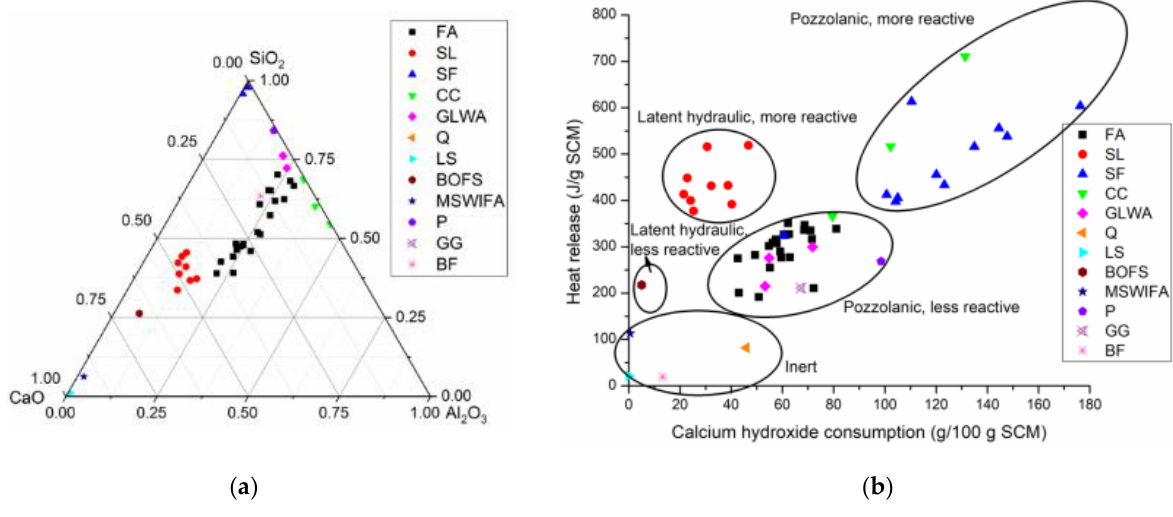
Figure 1. Characteristic of various SCMs: ( a ) ternary phase diagram showing SiO2, Al2O3, and CaO amounts for various SCMs [4]; ( b ) results from isothermal calorimetry and thermogravimetry analysis on various types of SCMs and their classification. Key to SCM types: fly ash (FA), ground granulated blast furnace slag (SL), silica fume (SF), calcinated clay (CC), ground lightweight aggregates (GLWA), quartz (Q), ground limestone (LS), basic oxygen furnace slag (BOFS), municipal solid waste incineration fly ash (MSWIFA), ground pumice (P), ground glass (GG), and basalt fines (BF) [4].